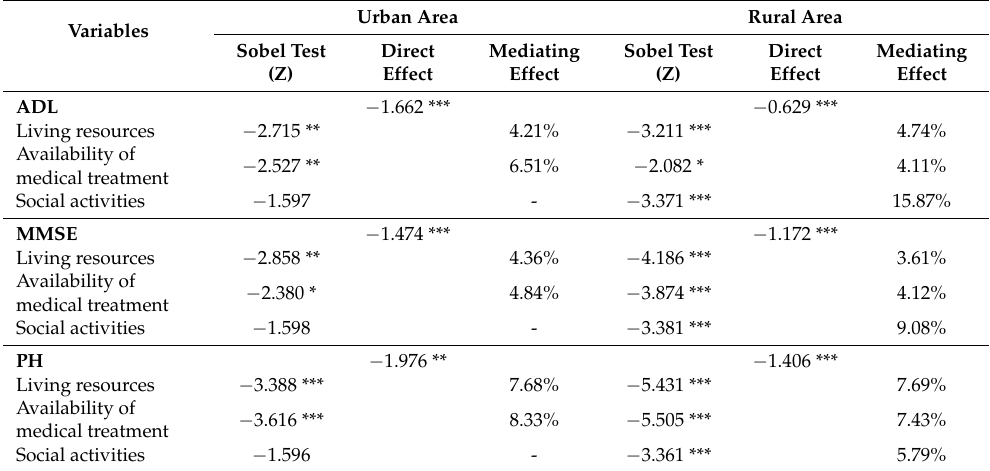
Table 8. Mediating effect between an empty nest and elders’